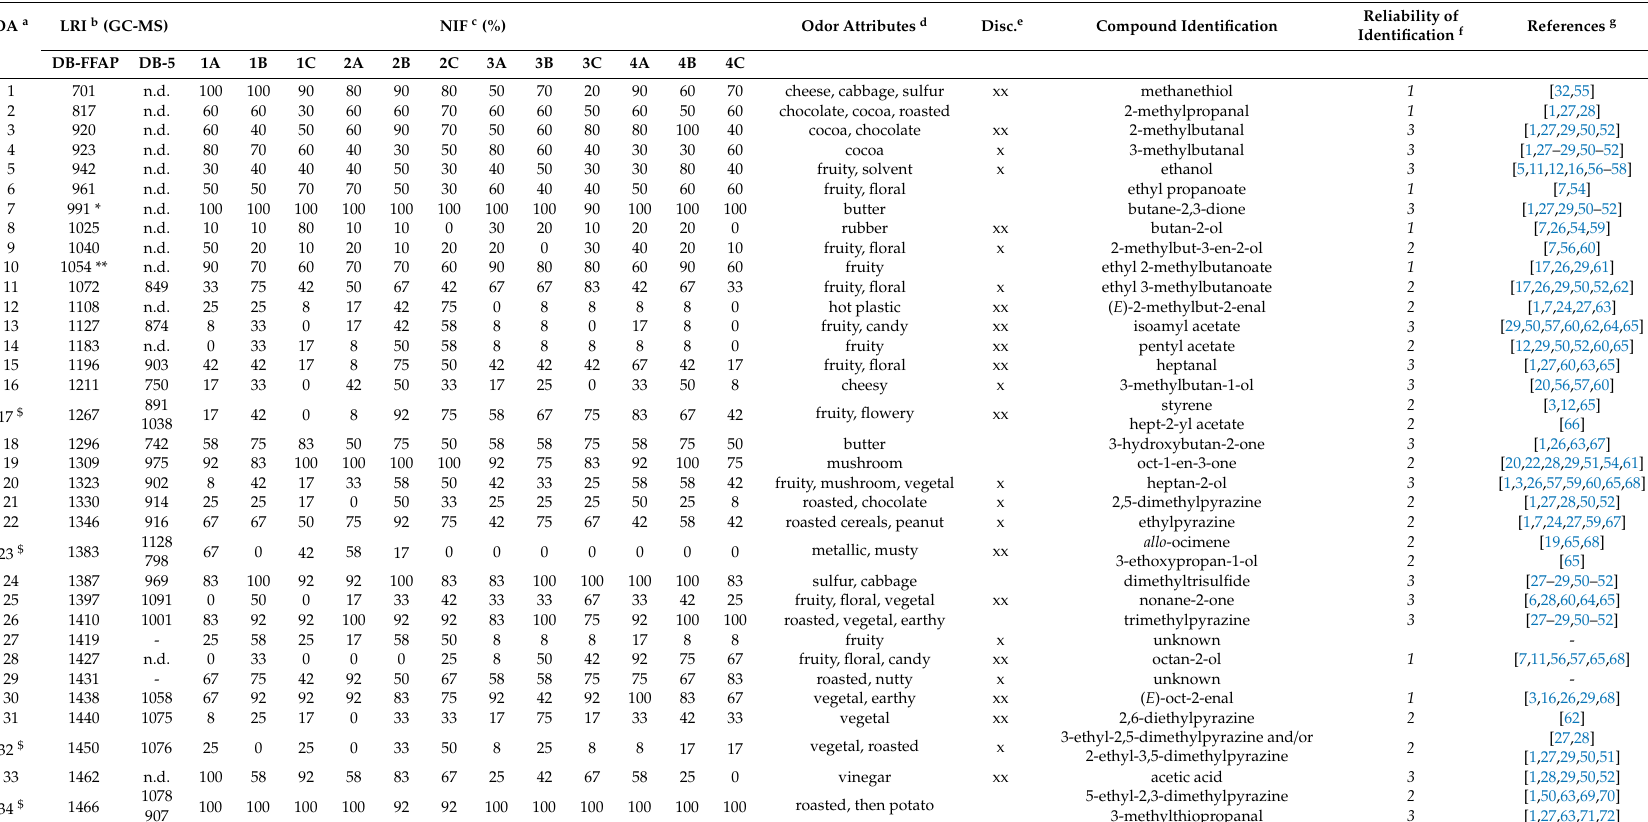
Table 1. Characterization of olfactive areas (OAs) of the 12 chocolate samples (1A to 4C) for which the nasal impact frequency (NIF) ≥ 50% in at least one sample. a OA number, OA 1 to 10 obtained in HS-SPME-GC-MS, OA from 11 obtained with SAFE extracts; b Linear retention indices (LRIs) calculated in GC-MS on DB-FFAP and DB-5 columns, “n.d.” = not detected, “-“ = irrelevant; c NIF values in each sample (%); d Odor attributes given by the panel; e Discriminant OA: x = NIF di ff erence > 30% between at least 2 samples, xx = NIF di ff erence > 50% between at least 2 samples (see text); f Reliability of identification: 1 = MS, LRIs and odor identical to published data and / or data found in databases, 2 = 1 with additional MW confirmed by CI, 3 = 2 with additional injection of standards on equivalent DB-5 and / or DB-FFAP columns, 4 = after MDGC-MS / O; g Compounds identified in references related to cocoa and / or dark chocolate (not exhaustive list) and according to the database Volatile Compounds in Food (VCF): (http: // www.vcf-online.nl)